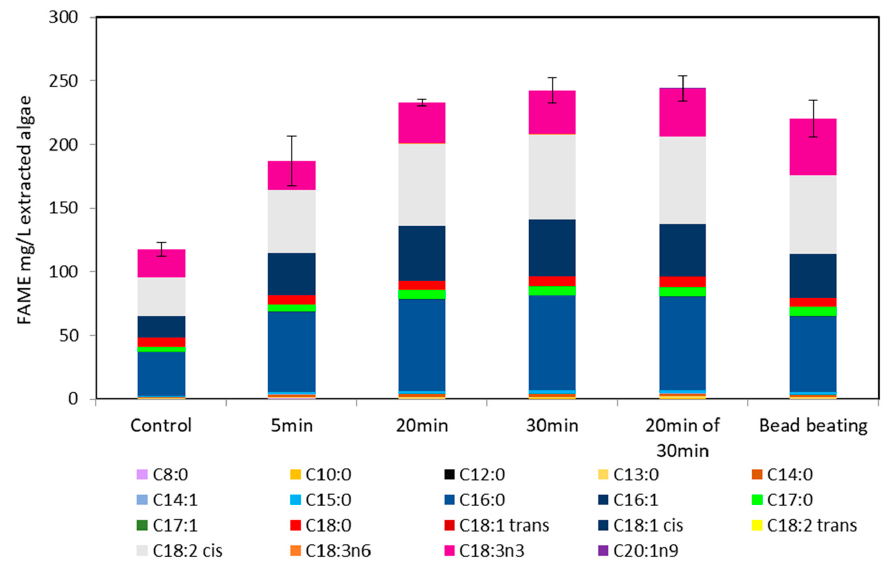
Figure 6. Comparison of biodiesel yield from UV light exposed M. inermum. Fatty acid methyl ester yields from both bead beating and ultraviolet light irradiation disruption is shown above. Yields are scaled to represent transesterified lipids from 1 L of culture. UVB intensity at 1.5 W/cm 2 . 20 min over 30 min represents 40 s of irradiation per min for 30 min. Irradiation, bead beating, and control carried out as in Materials and Methods. Error bars represent the range. n = 2. The legend indicates different FAME chain lengths.